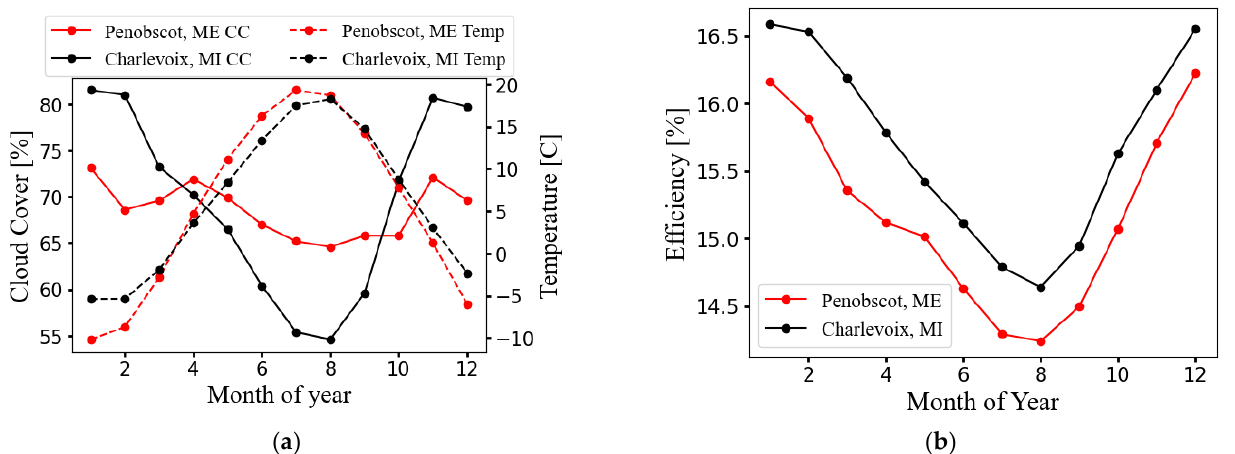
Figure 9. ( a ) Comparison of seasonal cloud cover and ambient temperatures for case 2 indicated in Figure 5. ( b ) The temperature-dependent efficiency of PV panels for case 2 locations.